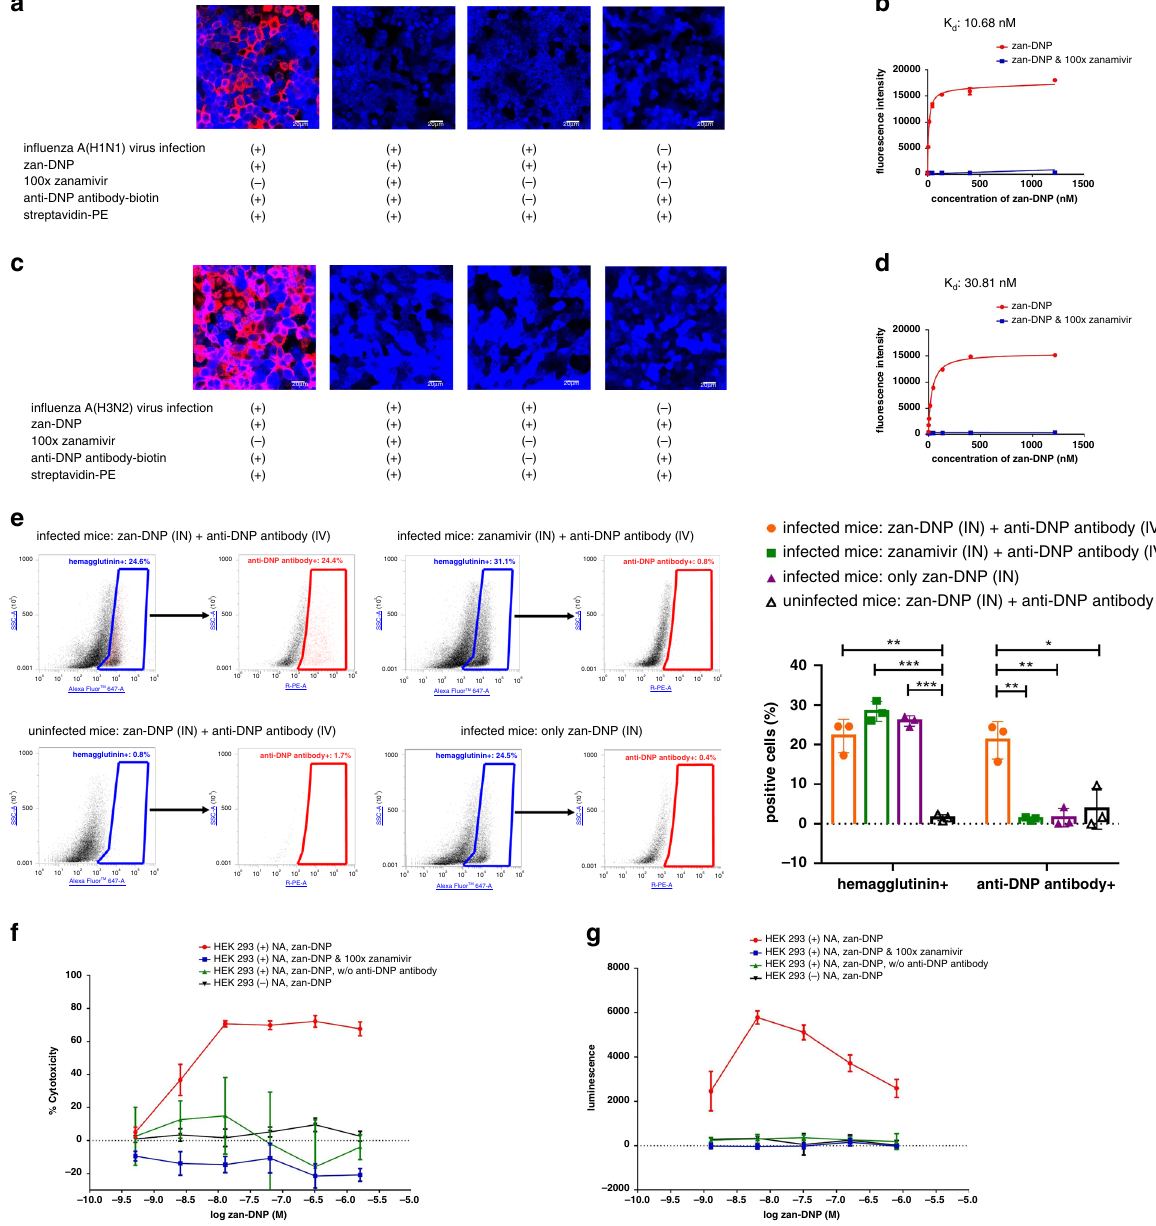
Fig. 3 Anti-DNP antibodies recruiting, complement dependent cytotoxicity (CDC), and antibody-dependent cellular cytotoxicity (ADCC) of neuraminidase expressing cells induced by zan-DNP. a and c Confocal micrographs of binding of biotinylated anti-DNP antibodies (visualized by streptavidin-PE) to the surface of A/Puerto Rico/8/1934 (H1N1) ( a ) and A/Aichi/2/1968 (H3N2) ( c ) virus-infected MDCK cells mediated by zan-DNP ( n = 3). Nuclear staining is shown in blue, and streptavidin-PE staining is shown in red. b , d Binding of anti-DNP antibodies to in fl uenza A(H1N1) ( b ) and A (H3N2) ( d ) virus-infected MDCK cells determined by quantitating the fl uorescence of cell-bound streptavidin-PE in the presence of anti-DNP antibodies as a function of the concentration of zan-DNP ( n = 3). All the virus-infected cells were used 24 h post-infection for the above studies. e Flowcytometry analyses of recruitment of anti-DNP antibodies to virus-infected cells mediated by zan-DNP in vivo ( n = 3). A/California/07/2009 (H1N1)pdm09 virus- infected mice (3 mice/group) were fi rst given zan-DNP and anti-DNP antibodies (3 days post-infection). 12 h later, the cells digested from the lung of virus- infected/uninfected mice were stained fi rst with anti-hemagglutinin antibodies and then labeled with dye conjugated secondary antibodies against anti- hemagglutinin antibodies and anti-DNP antibodies. Left: selected fl ow cytometry plots; Right: summary graph. Statistical difference of antibody stained positive cells (%) between indicated two groups was analyzed by two-sided t test (* P < 0.05, ** P < 0.01, *** P < 0.001, see exact P values in Supplementary Table 1). f CDC mediated killing of N1 neuraminidase transduced and nontransduced HEK 293 cells mediated by zan-DNP in the presence of anti-DNP antibodies and complement-preserved rabbit serum ( n = 3). g Antibody-dependent cellular cytotoxicity (ADCC) of N1 neuraminidase transduced and nontransduced HEK 293 cells mediated by zan-DNP in the presence of anti-DNP antibodies and human Fc γ RIIIa expressing effector cells ( n = 3). ADCC activity is proportio n al to the amount of fi re fl y luciferase produced by effector cells (detected as the luminescence intensity). The coding sequence of N1 neuraminidase for the transduction of HEK 293 cells is from strain A/Puerto Rico/8/1934 (H1N1); Data are presented as mean values ± SD ( n =